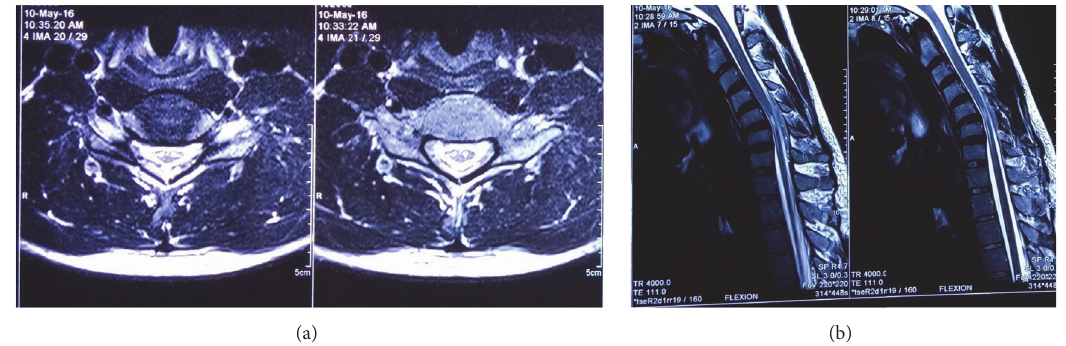
Figure 2: (a) MRI showing focal symmetrical atrophy of spinal cord with intramedullary T2 hyperintensity. (b) MRI showing forward displacement of the posterior subdural sac on flexion of neck, with prominent epidural